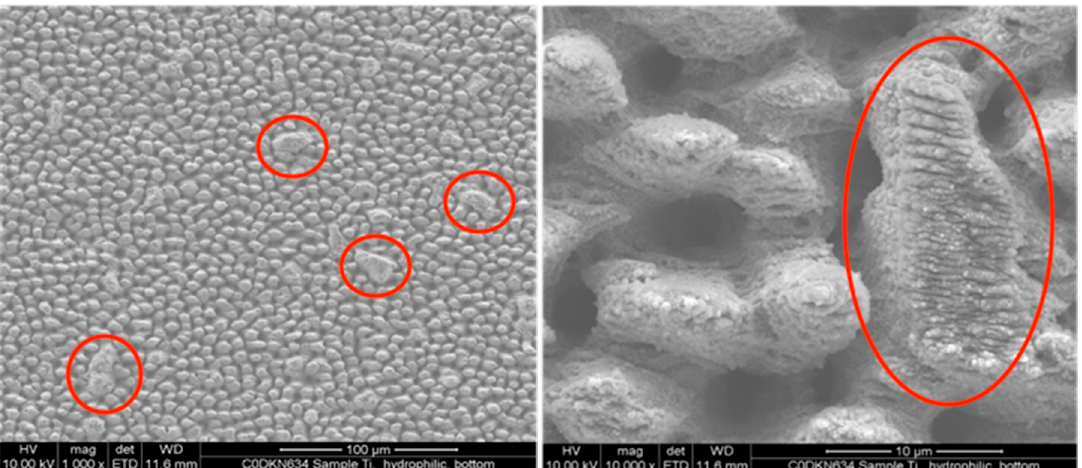
Figure 3. The fabrication of homogeneous hierarchical structures on a metal surface that resulted in hydrophobic traits, presented with different resolutions of 100 µm (left) and 10 µm (right) scale bars.